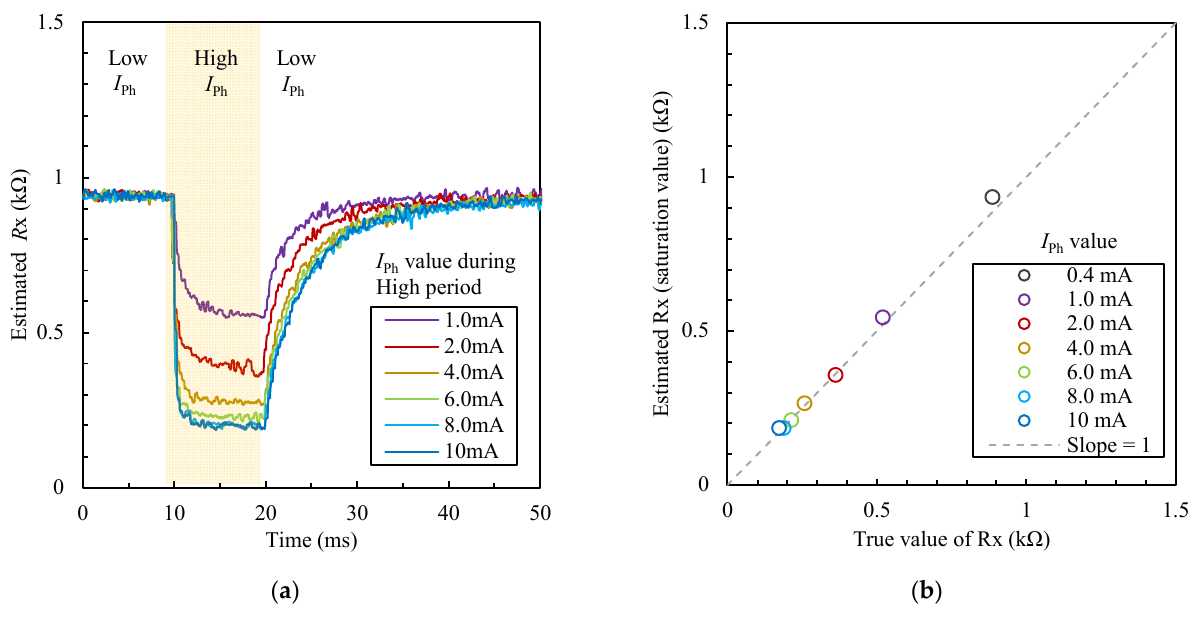
Figure 10. Resistance R x of each I Ph value for a CdS photocell during the high period using the proposed FPGA-based processor: ( a ) time–resistance curves of R x at each I Ph value; ( b ) saturation value at each I Ph value. Circuit parameters of R x were estimated and converted to the voltages for each segment (four cycles).